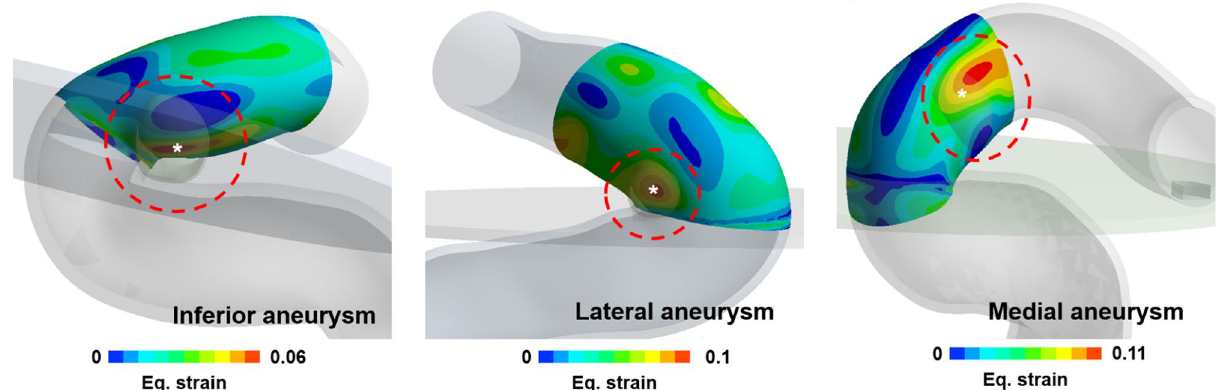
Figure 8. Examples of FSI results by paraclinoid aneurysm types. The strain distributions for paraclinoid models which have different aneurysm types were calculated using FSI analysis. A white star (*) indicates the location of aneurysm formation site. The strain was extracted at the systolic